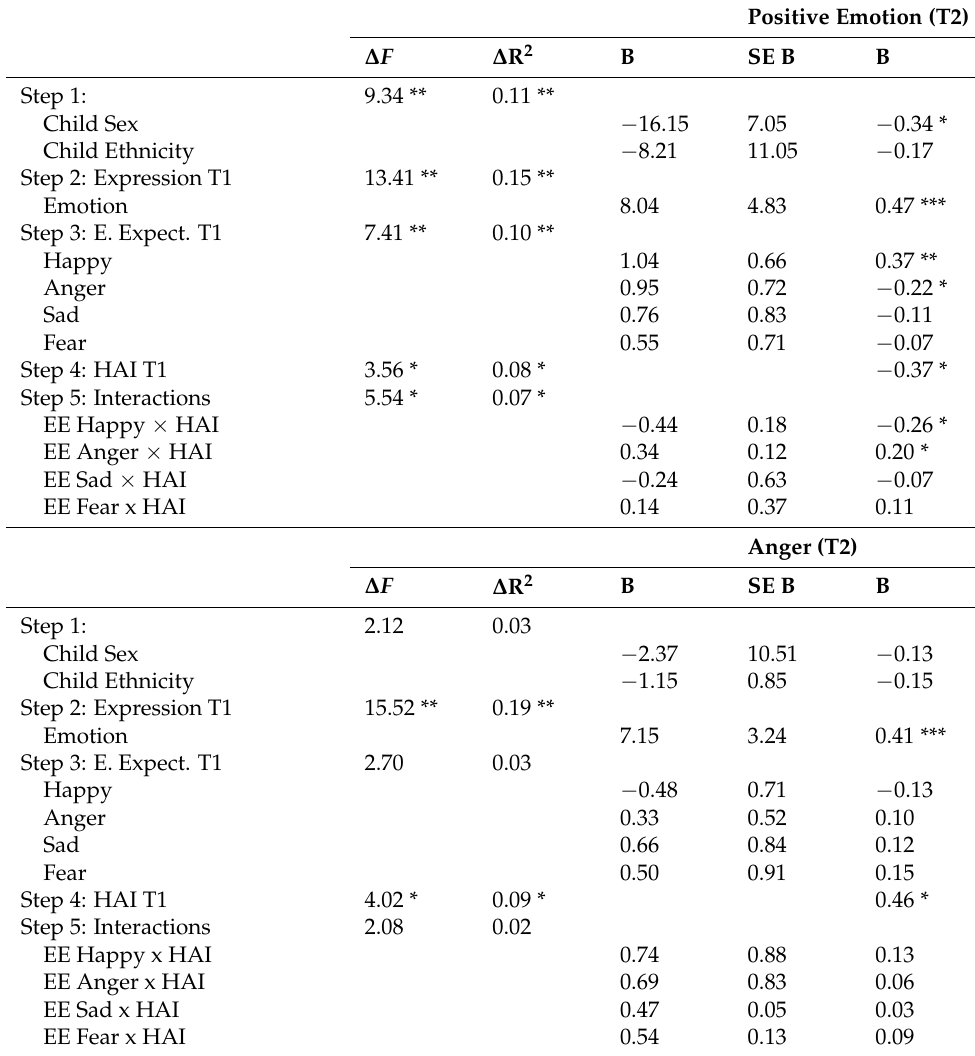
Table 4. Adolescent emotional expectancies and hostile attributions as predictors of adolescents’ expressions of emotion with